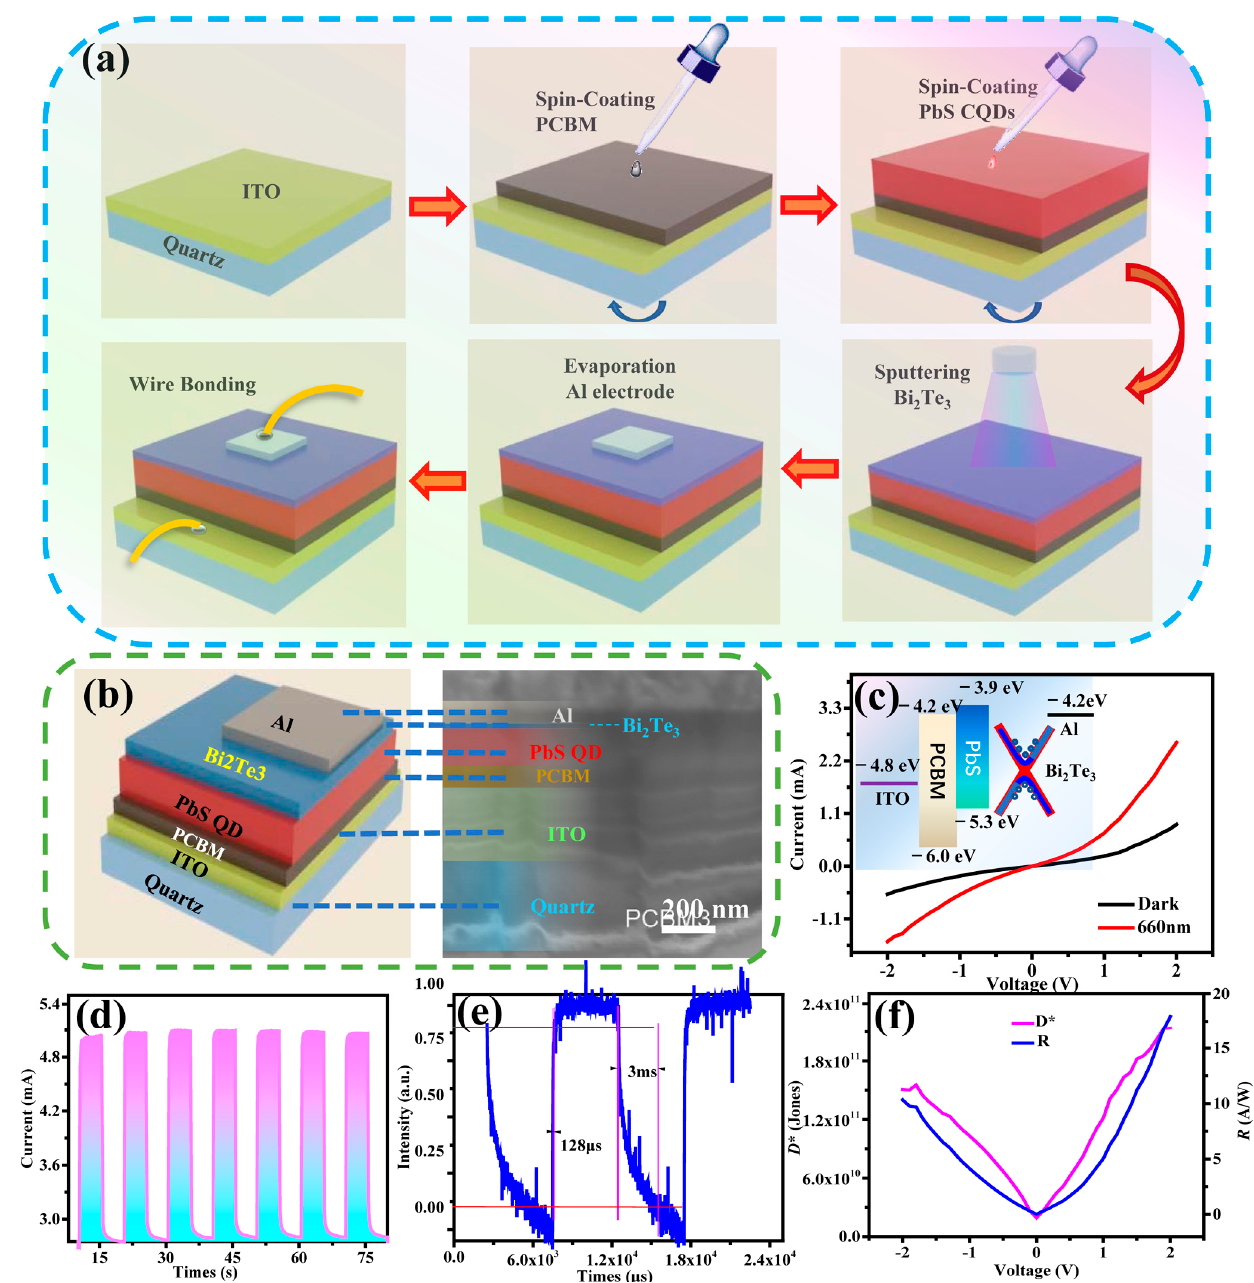
Figure 3. ( a ) Schematic diagrams illustrating fabrication process of the photodetector. ( b ) Schematic diagram and crosssectional SEM image of the photodetector. ( c ) I–V measurements under dark and light illumination at 660 nm (inset: energy band structure of the device). ( d , e ) Photocurrent switching behaviors. ( f ) Plot of responsivity ( R ) and detectivity ( D *) against voltage (V).